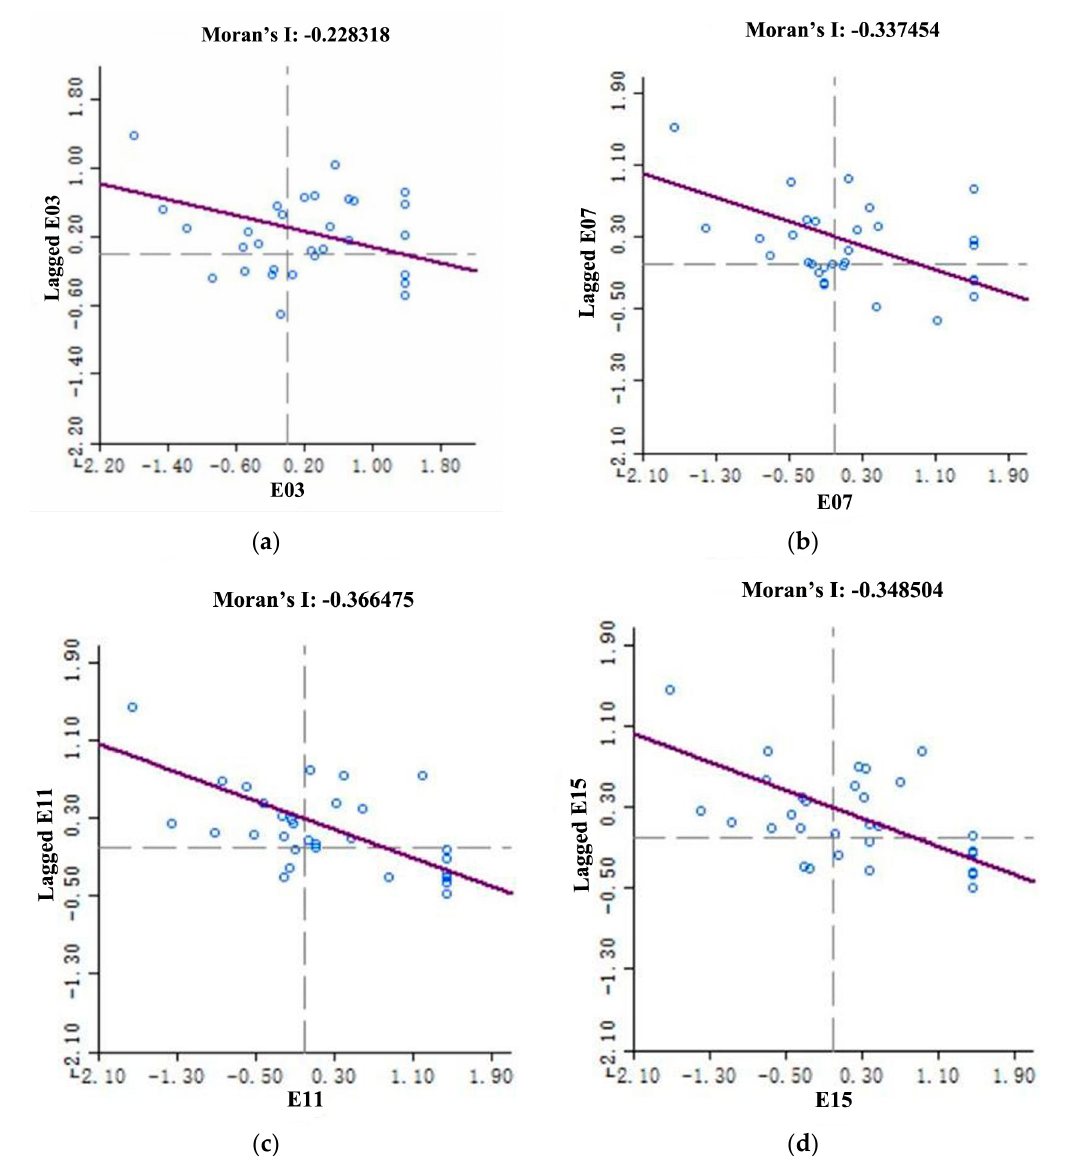
Figure 4. Moran scatter plots of land use eco-efficiency of provinces in China from 2003 to 2015 in selected